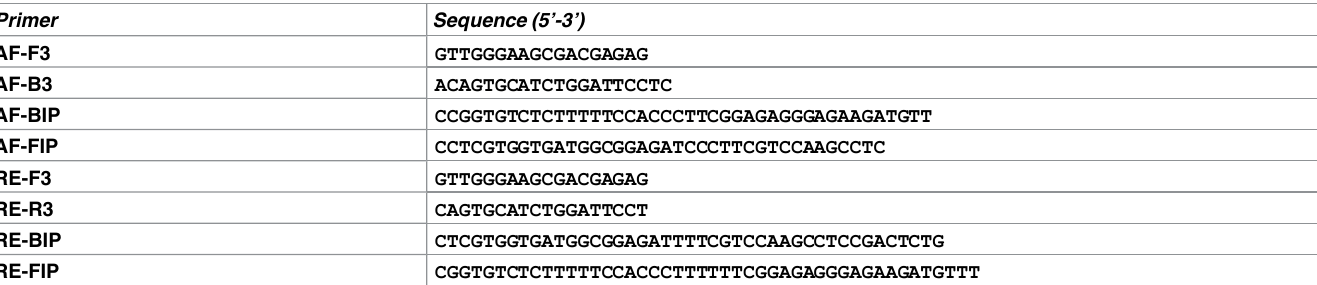
Table 1. Nucleotide sequences of 2 groups of LAMP primers (AF and RE) designed in this study. Primer Sequence